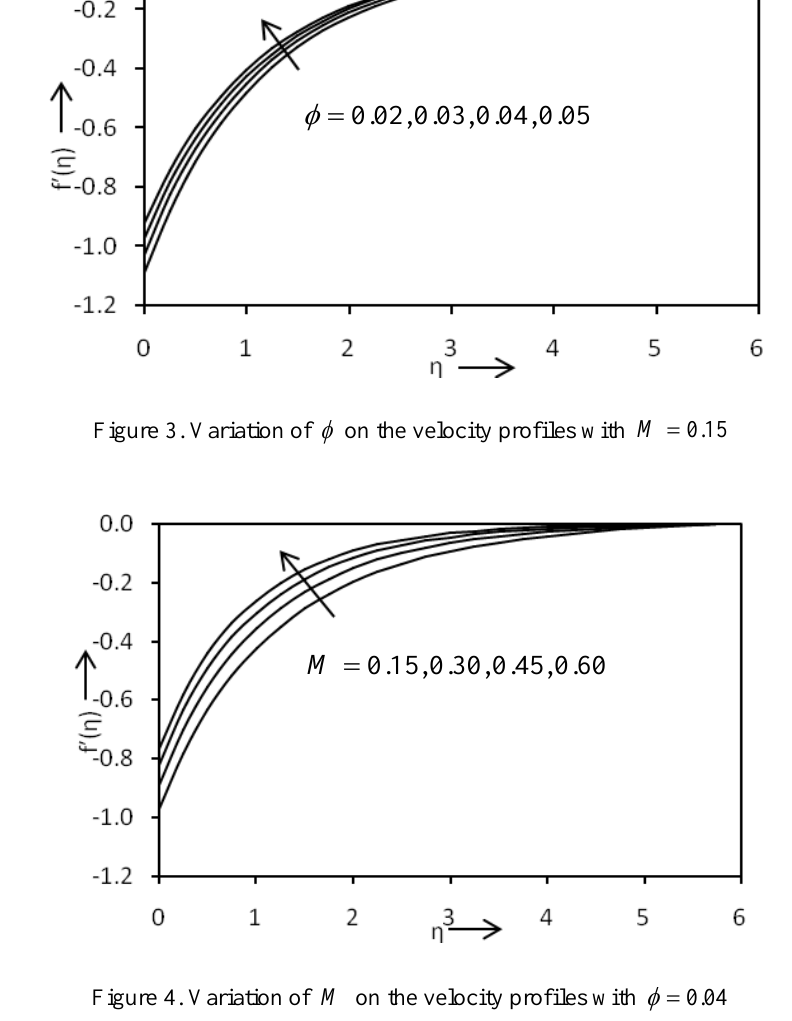
Figure 4. Variation of M on the velocity profiles